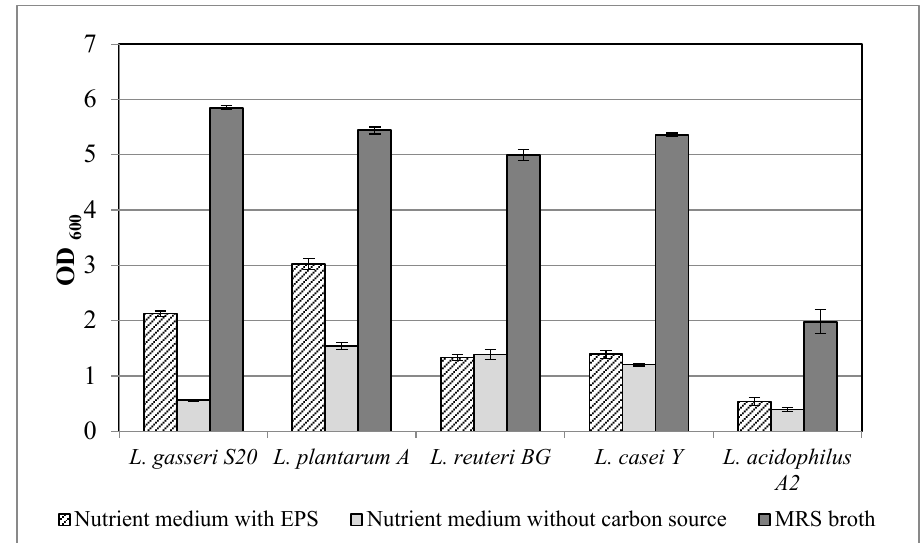
Figure 2. Utilization of exopolysaccharides (EPS) by probiotic lactic acid bacteria.